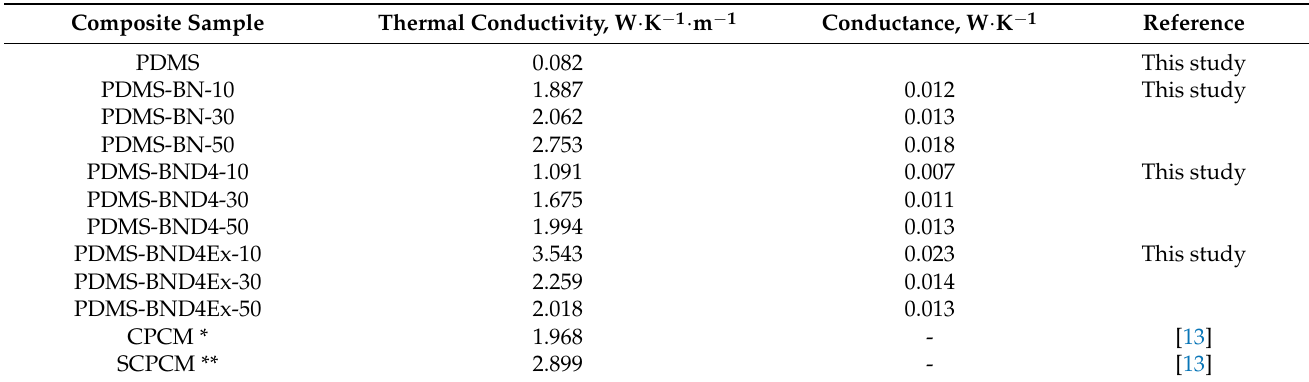
Table 3. Thermal parameters of the